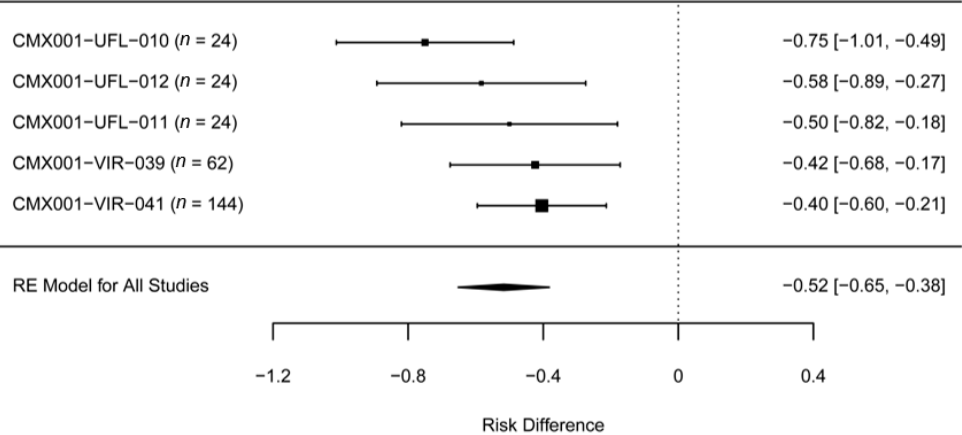
Figure 1. Forest plot of BCV efficacy data in the rabbitpox model. The vertical dotted line is a reference for no risk difference (i.e., no drug effect). All studies included equal numbers of male and female rabbits. Studies CMX001-UFL-010, -011, and -012 were conducted at the University of Florida [14]. In these studies, BCV was administered orally at 20 mg/kg beginning at the first observation of lesions. In Study UFL-010, animals received a total of three doses of 20 mg/kg, one dose every 48 h (20/20/20 mg/kg q48h), while in Studies UFL-011 and -012, the animals received 1 or 2 doses, respectively. Studies CMX001-VIR-039 and -041 were conducted at Battelle [15,16]. In Study VIR-039, BCV was administered at the first observation of lesions. Animals received 5/5/5, 20/5/5, or 20/20/20 mg/kg q48h. In the pivotal study VIR-041, BCV was administered at the first observation of fever, or was delayed by 24, 48, or 72 h after fever. Animals received 20/5/5 mg/kg q48h. Treatment effect was estimated by calculating the risk difference for each study. A pooled estimate of the risk difference across all studies was estimated using meta-analysis methodology. For calculation of the risk difference in each study (right column (95% CI)), the treatment groups were combined into one group of BCV-treated animals, regardless of the level of efficacy in each dose group. The pooled estimate of the risk difference is 52% (95% CI: 65% to 38%), meaning the average mortality in BCV-treated animals is 52% lower on an absolute basis. Removing BCV doses above those used in Study CMX001-VIR-041 (20/5/5 mg/kg q48 h) from the analysis (i.e., 20/20/20 mg/kg q48h and 20/20 mg/kg q48h) shifts the pooled estimate of the risk difference to 41% (95% CI: 55% to 27%).